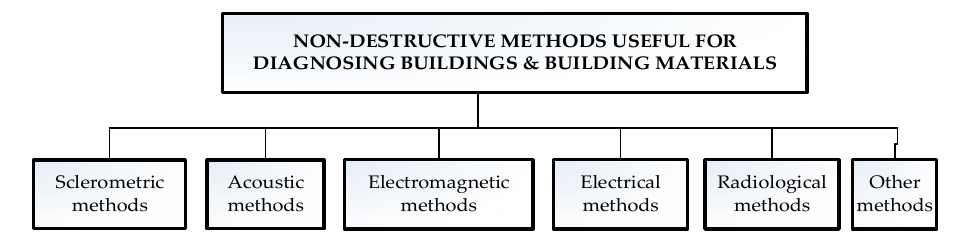
Figure 2. General classification of non-destructive methods useful for diagnosing buildings and building materials [3].